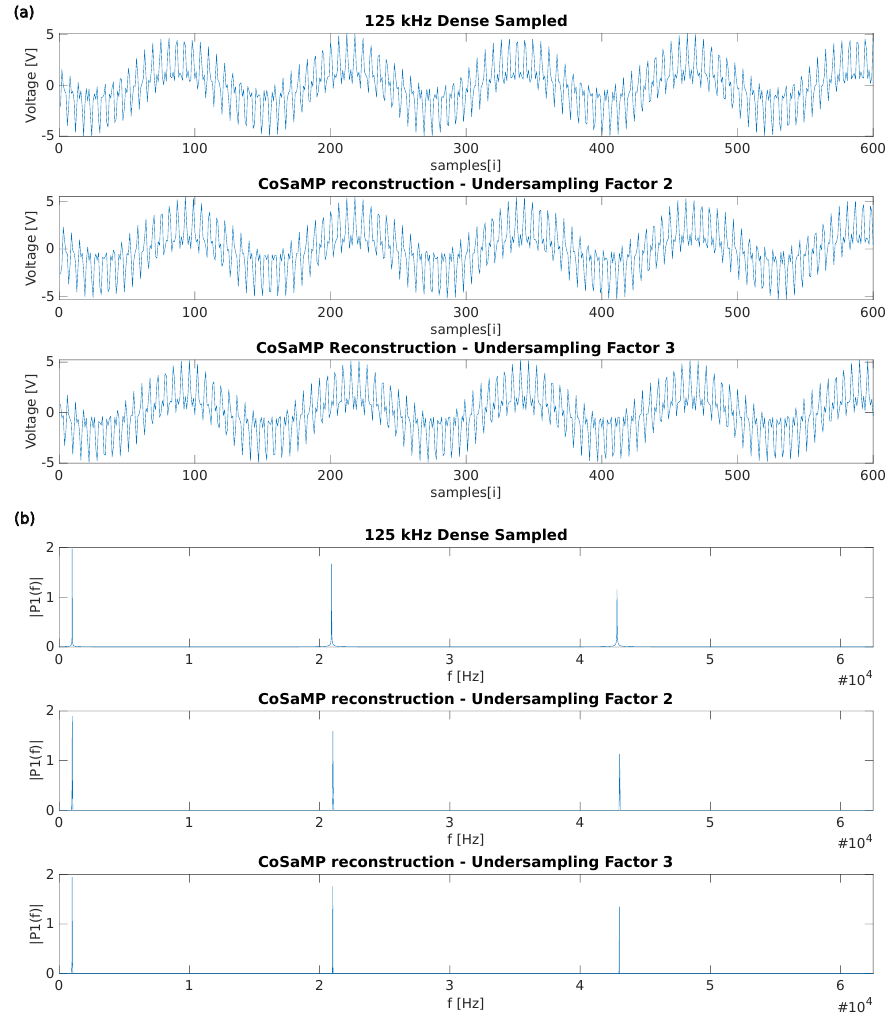
Figure 3. Captures of the test signal using the three auto − generated firmwares. The test signal was a combination of three sine waves with a frequency of 1 kHz, 21 kHz and 43 kHz. To validate the undersampled data, reconstruction was done using the CoSaMP algorithm. In panel ( a ), the time − domain representation can be seen, whereas in panel ( b ), the frequency domain representation is